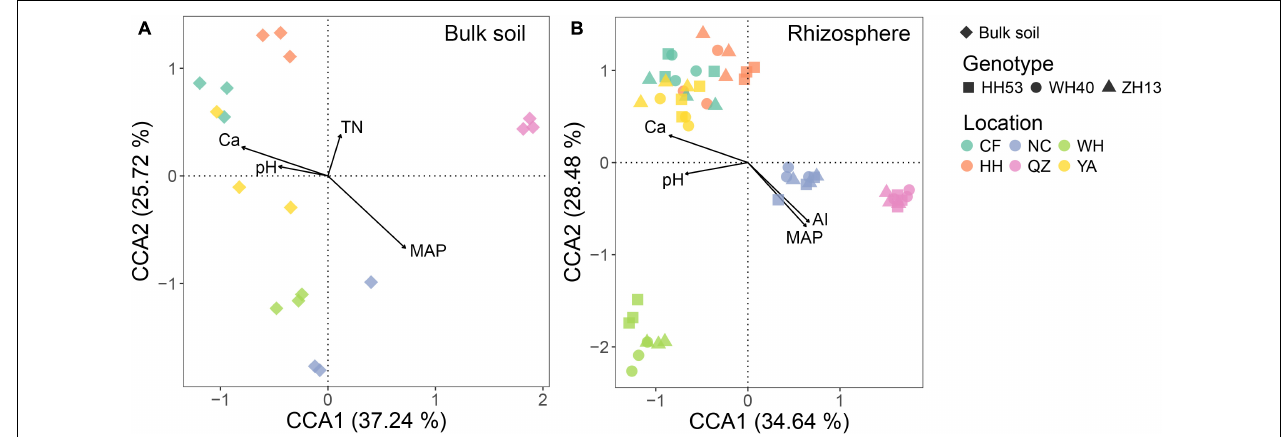
FIGURE 4 | Canonical correspondence analysis (CCA) showing the correlations among environmental factors (edaphic and climatic factors) and protist communities from the bulk soil (A) and rhizosphere (B) of soybean fields in China. TN, total nitrogen; pH, soil pH; MAP, mean annual precipitation; AI, aridity index.